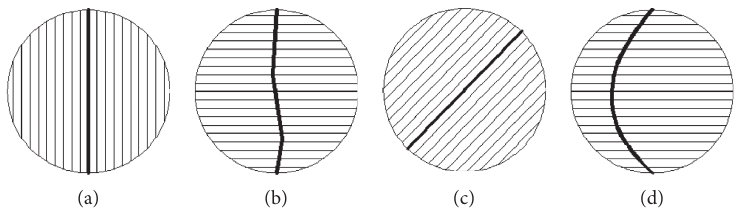
Figure 14: Schematic representation of different fracture types in the Brazilian test. (a) Tensile failure and central fracturing along a bedding plane, (b) tensile failure and central fracturing along a previously intact plane, (c) shear failure and off-centre fracturing along a bedding plane, and (d) tensile failure and noncentral fracturing along a previously intact plane.